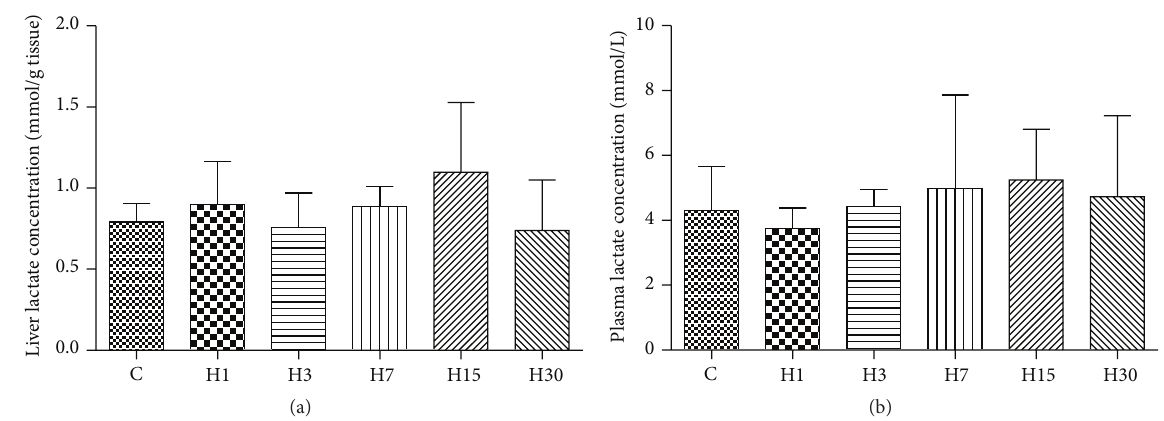
Figure 2: Lactate concentrations in the rat livers (a) and lactate concentrations in the rat plasma (b) were measured by spectrophotometry in control rats (no HA exposure, 𝑛 = 6 ) and rats exposed to HA ( 𝑛 = 6